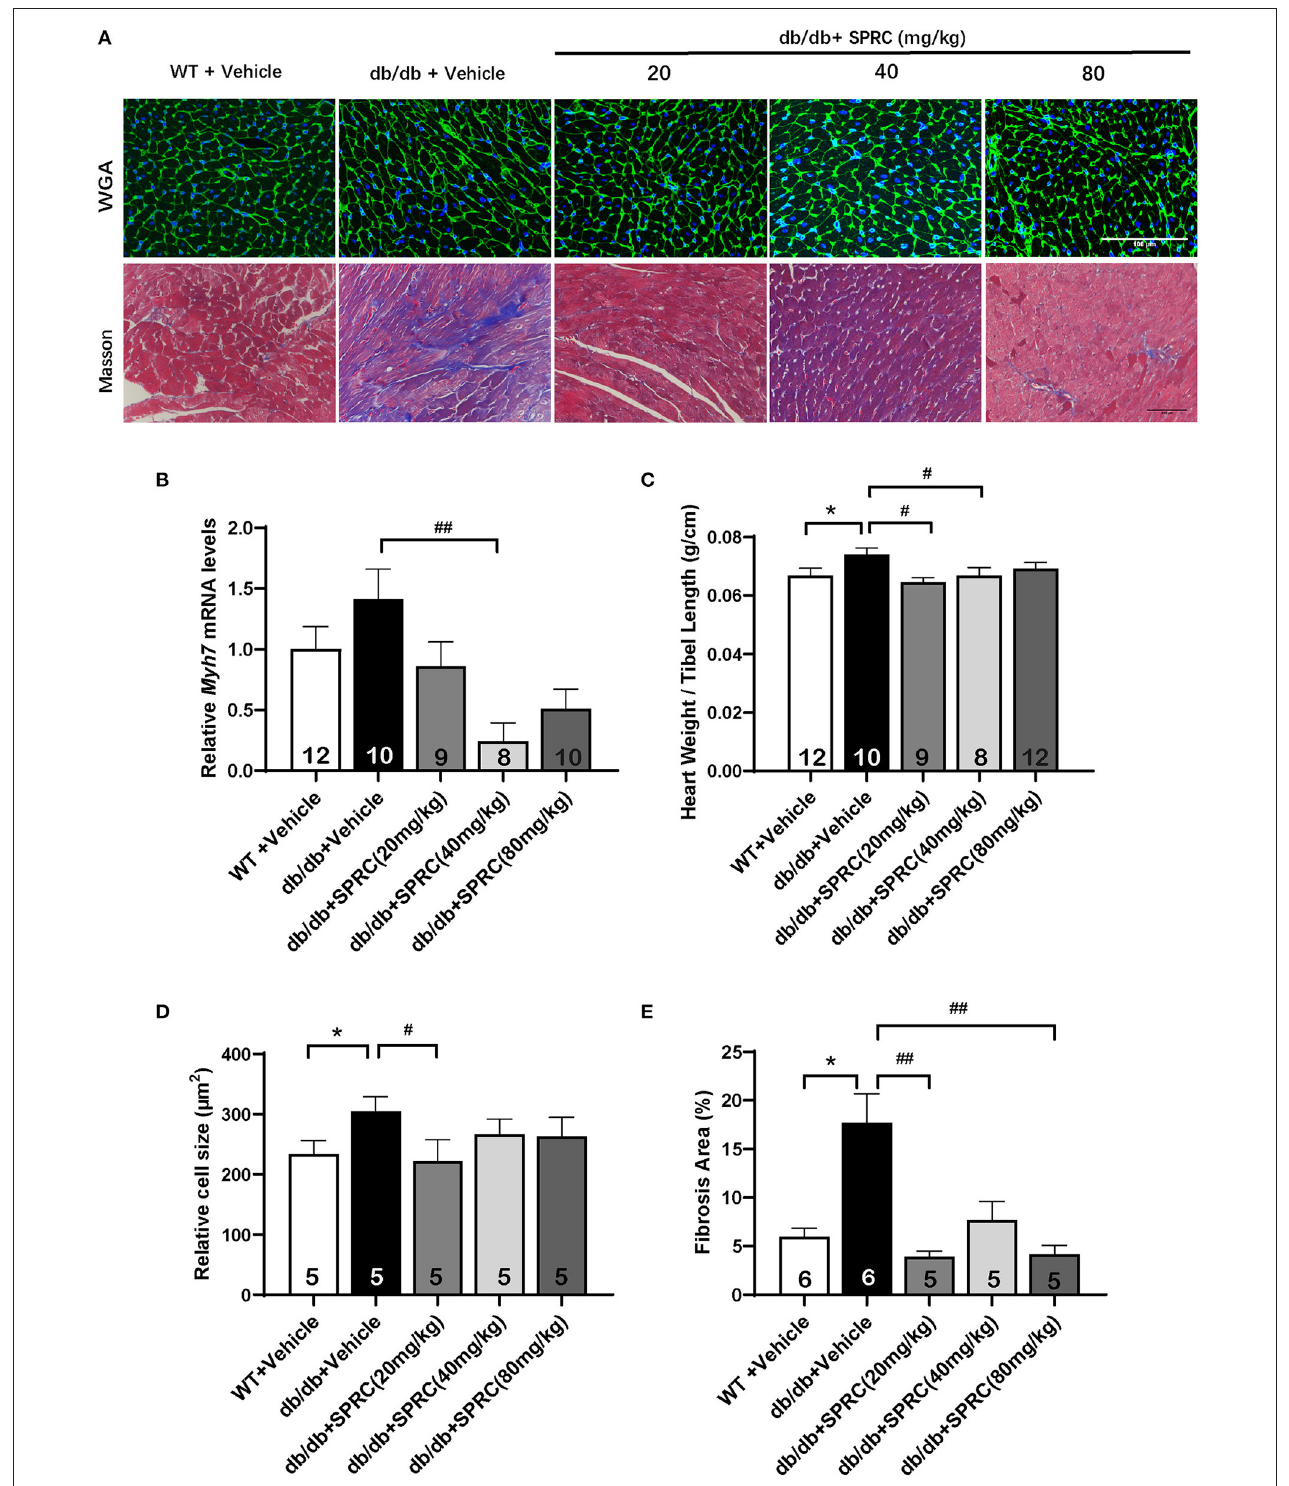
FIGURE 2 | SPRC treatment improves myocardial hypertrophy and fibrosis in db/db mice. Vehicle or SPRC (20, 40, or 80 mg/kg/day) was orally administered to WT mice or db/db mice for 12 weeks. Heart tissue specimens were collected. (A) Wheat germ agglutinin (WGA) and masson staining of myocardium were performed. (B) mRNA levels of Myh7 in heart tissue were determined by real-time qPCR. mRNA levels of Gapdh was used as reference for normalization ( n = 8–12). (C) The ratio of heart weights (HW) and tibia lengths (TL) was calculated ( n = 8–12). Average cell area ( n = 5) (D) and fibrosis area ( n = 5–6) (E) were shown. Values are presented as means ± SEM. * P < 0.05 vs. WT + Vehicle group, # P < 0.05, ## P < 0.01 vs. db/db + Vehicle mice.